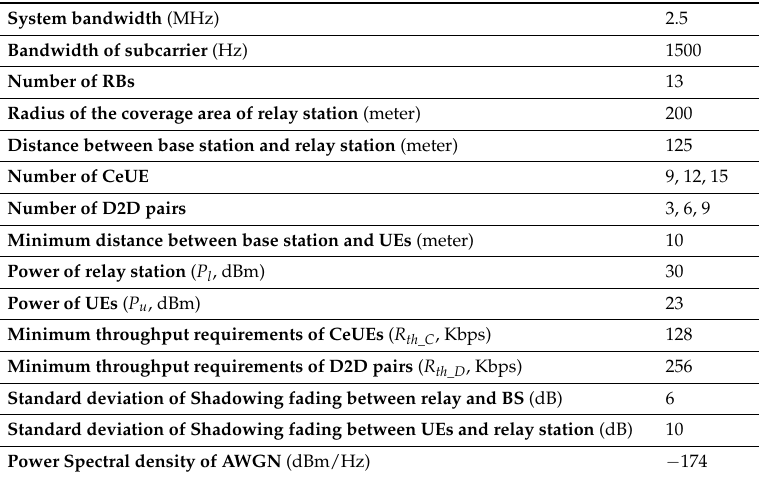
Figure 2. D2D pairs deployed on the circle around the relay station. Table 1. System simulation parameters .